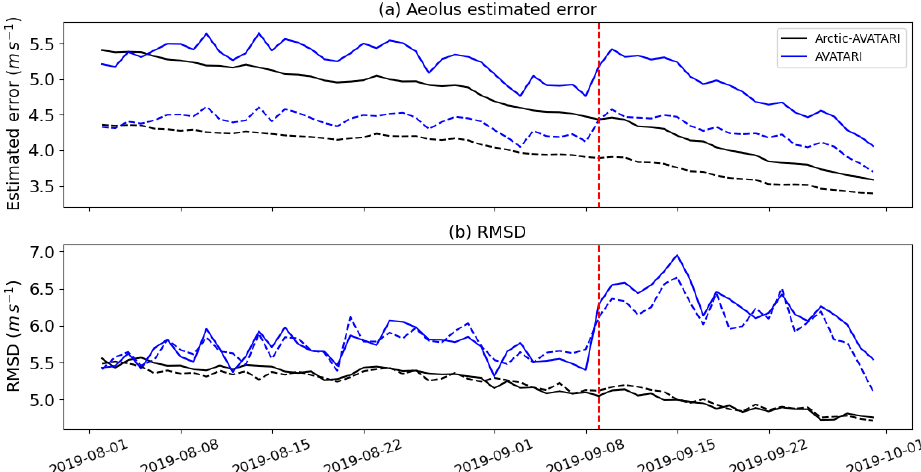
Figure 7. Time series of (a) Aeolus L2B estimated error of Rayleigh winds and (b) RMSD between the ECCC-B and Aeolus 2B06 (solid) and 2B10 (dashed) data from 2 August to 30 September 2019. The data are averaged over the region with a different range bin setting for the AVATAR-I campaign (blue) and over the rest of the Arctic